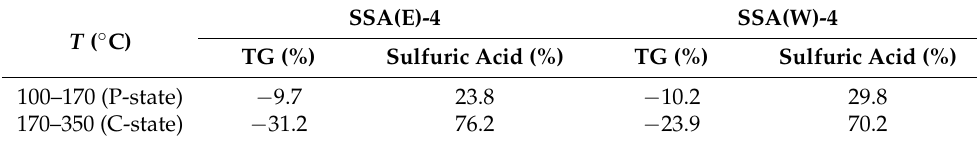
Figure 1. TG curves of SSA(E) − 4 and SSA(W) − 4. Table 1. Amounts of P − and C − state sulfuric acid in SSA(E) − 4 and SSA(W) − 4.